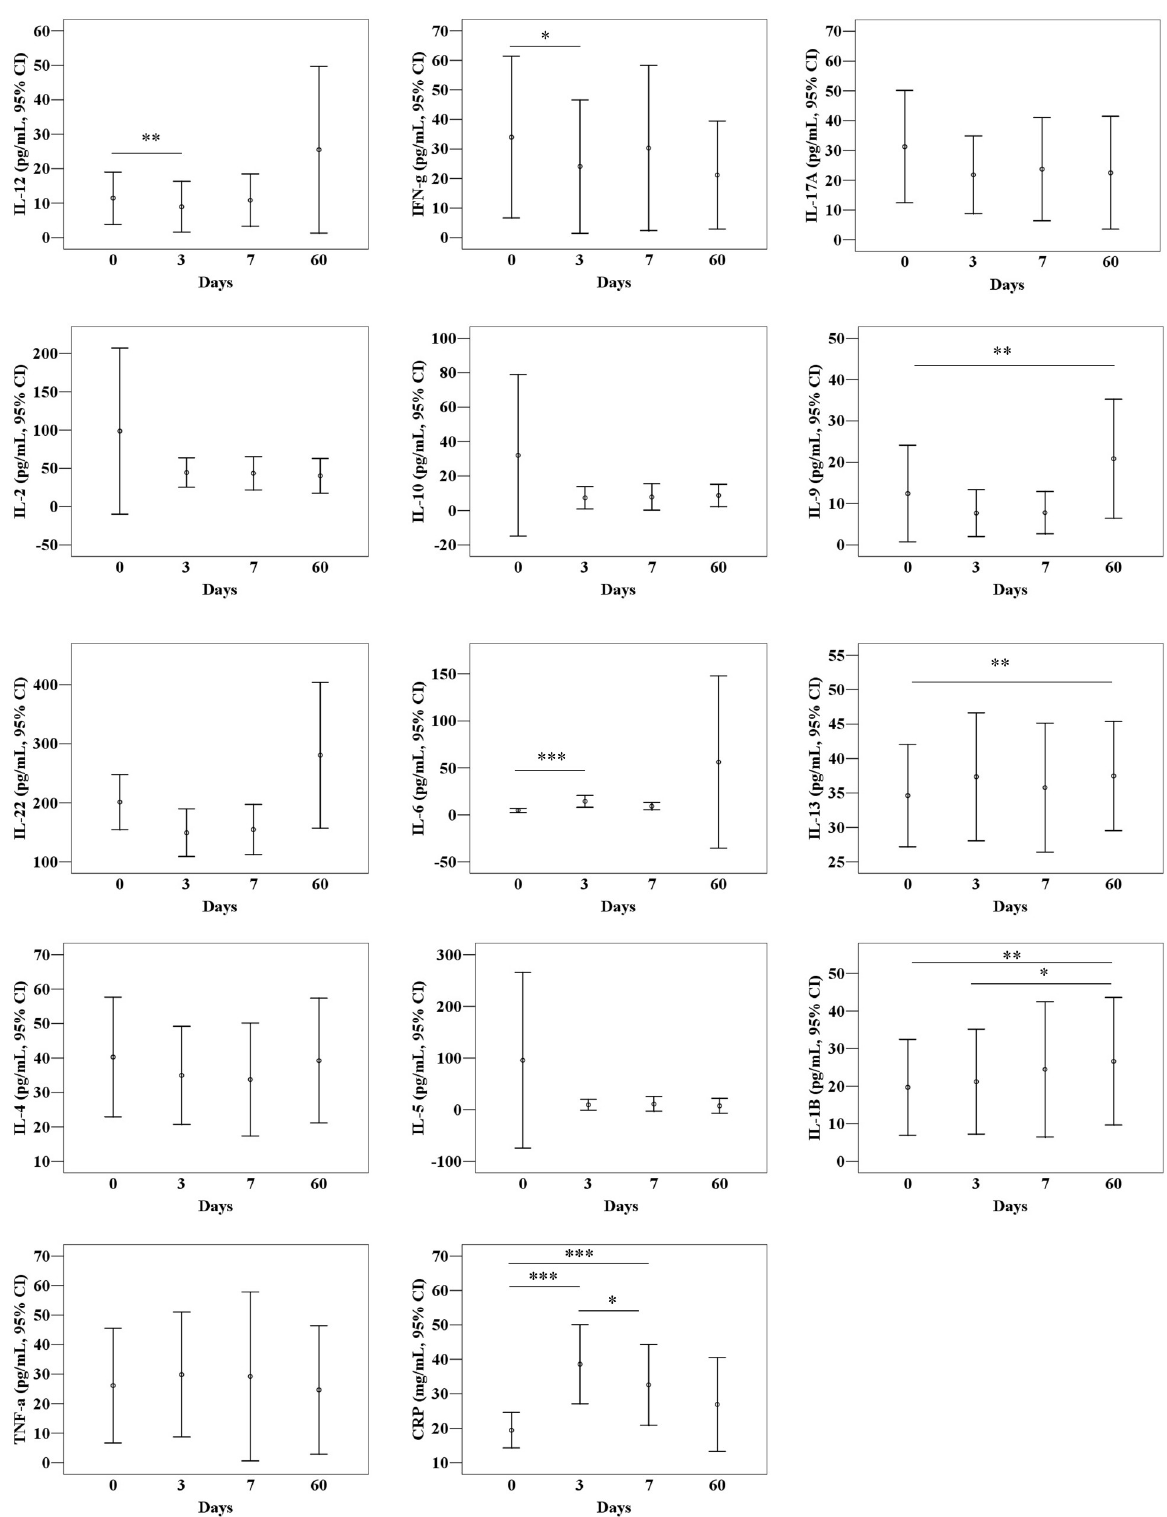
Fig 1. Cytokine concentrations at D0, D3, D7 and D60.